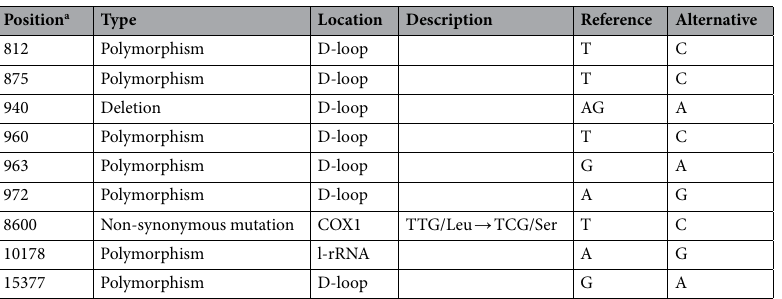
Table 4. Mitochondrial sequence variations specific for deltamethrin resistant L. salmonis isolates. The mitochondrial genome (mtDNA) was compared between deltamethrin resistant (IoA-02, IoA-03, IoA-10, NA01-O, NA01-P) and susceptible (IoA-00, IoA-01) L. salmonis strains to establish mutations associated with resistance. The mtDNA sequence of strain IoA-10 was established by PCR followed by Sanger sequencing within the present study, while that of the other strains has been reported previously 21 . a Numbering according to a L. salmonis mitochondrial reference genome established for a Scottish isolate (NCBI Accession number LT630766.1).